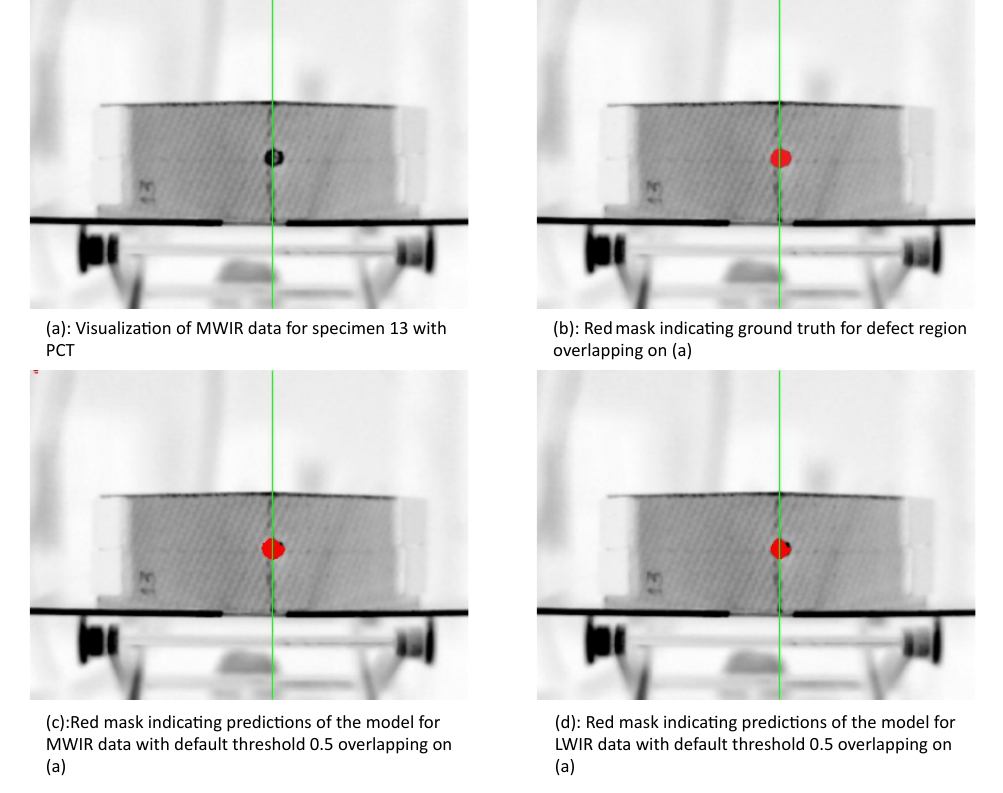
Figure 11. Visualization of results from specimen 13: The specimen was split into left and right parts; the left part was considered training data, and the right part was considered testing data. The green line denotes the splitting